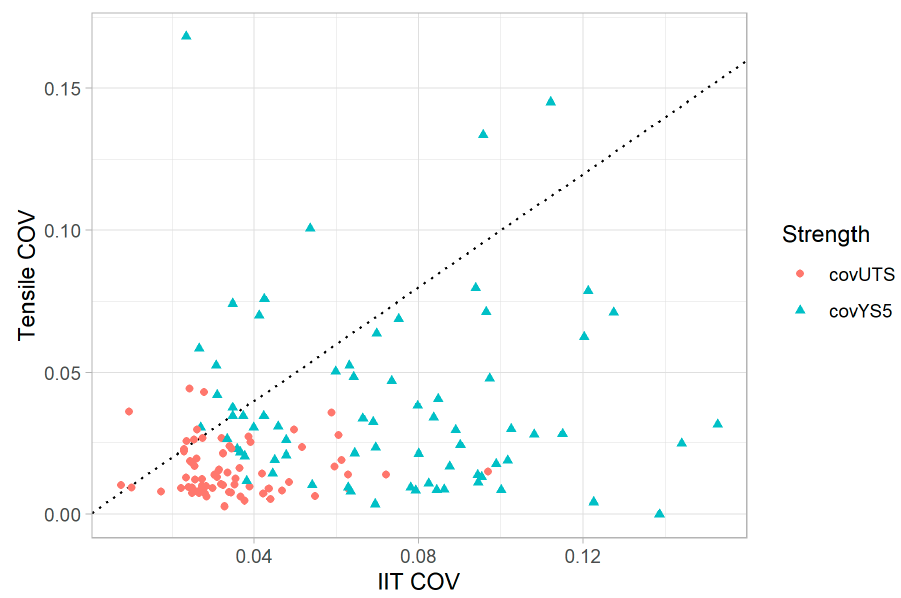
Figure 7. Tensile vs. IIT COV for both YS and UTS.